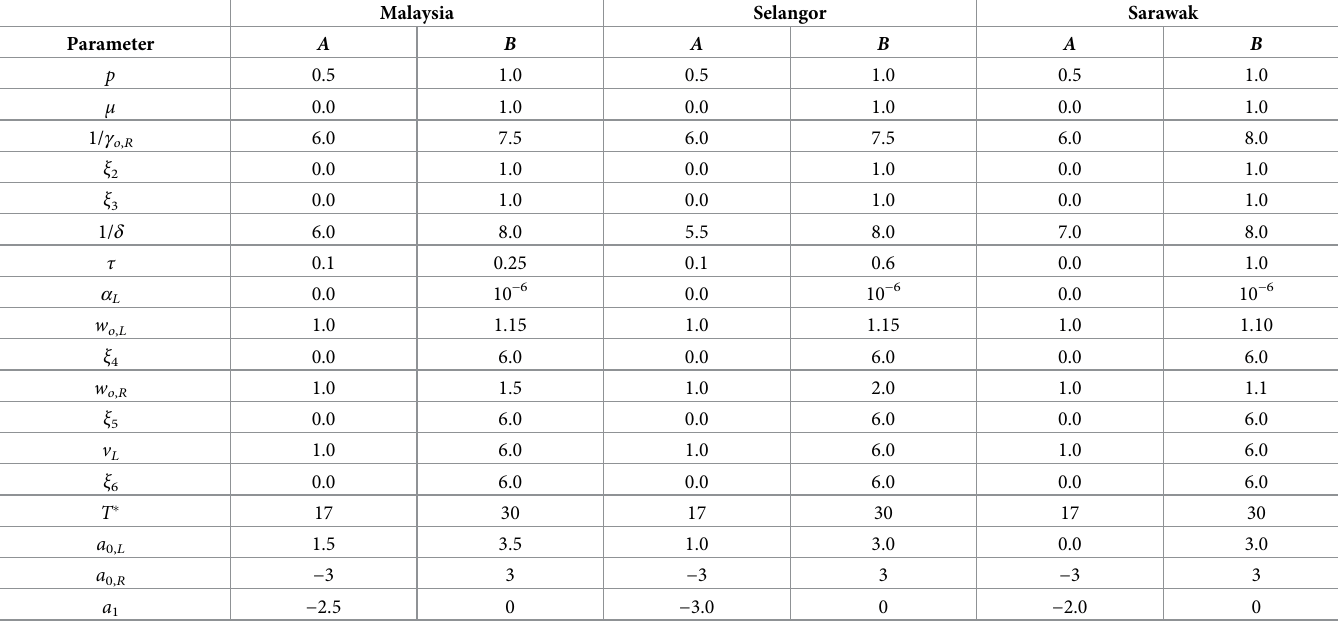
Table 1. Hyperparameter values for the reported